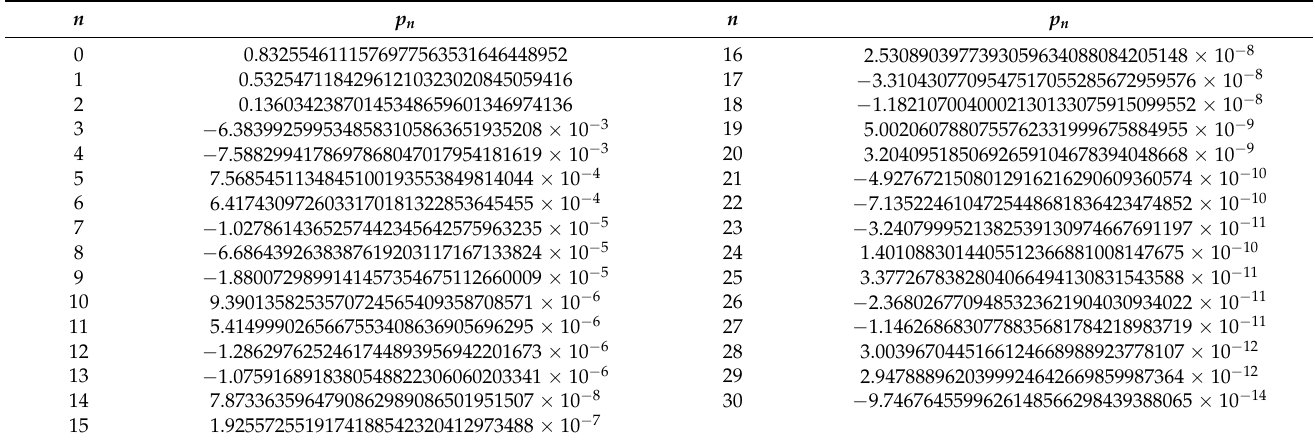
Table A1. The first 31 coefficients p n in Equation (9) with 32 significant digits.